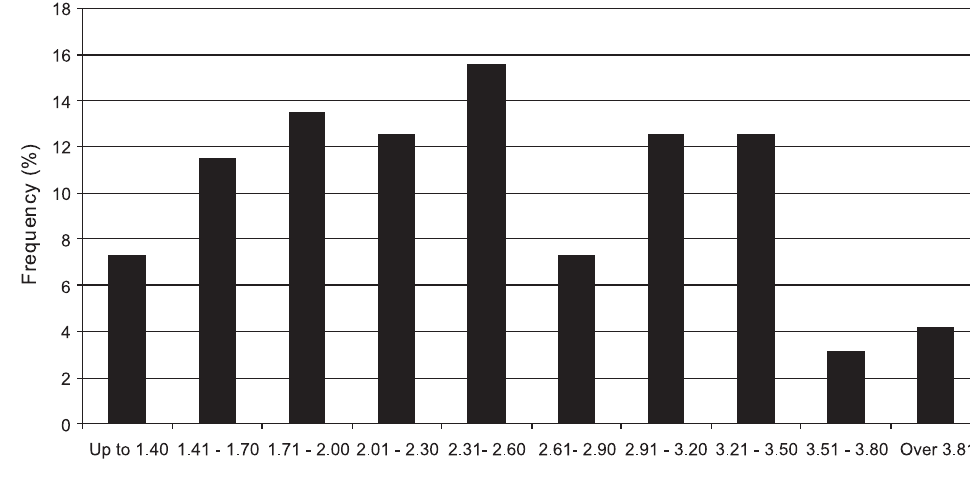
Figure 1 - Serum beta 2-microglobulin (Sb2M) levels in blood donors (mg/mL) plotted versus its frequency distribution in percentage.